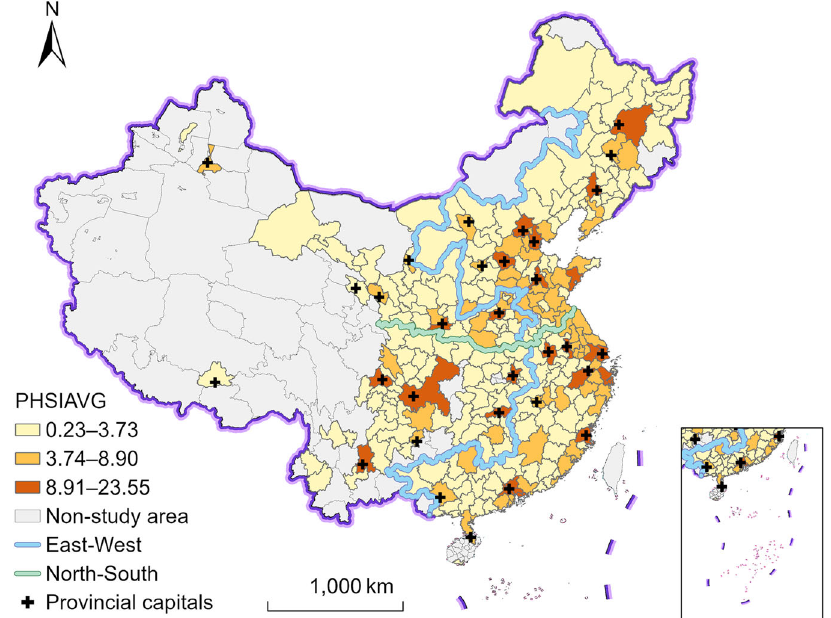
Fig. 2 Spatial distribution of the development levels of PHS. PHSI is divided into three grades according to the K -Means clustering method. The fi rst, second, and third grades range from 11.75 to 24.66, 4.81 to 11.74, and 0.20 to 4.80, representing the high, medium, and low PHS development levels, respectively. The map was developed by the authors using ArcGIS Pro Version 3.0.2, and the background map was issued by the Ministry of Natural Resources of the People ’ s Republic of China (drawing review No. GS (2020) 4619), as shown in the website: